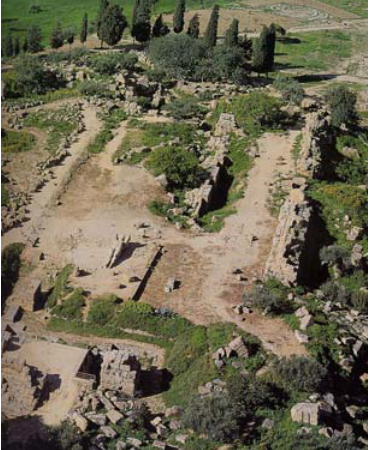
Figure 1. Ruins of the Temple of Olympian Zeus